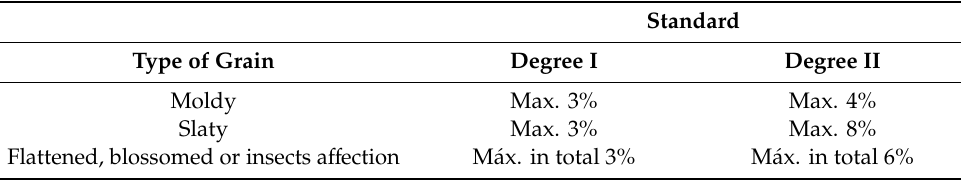
Table 4. Biophysical standards of cocoa.